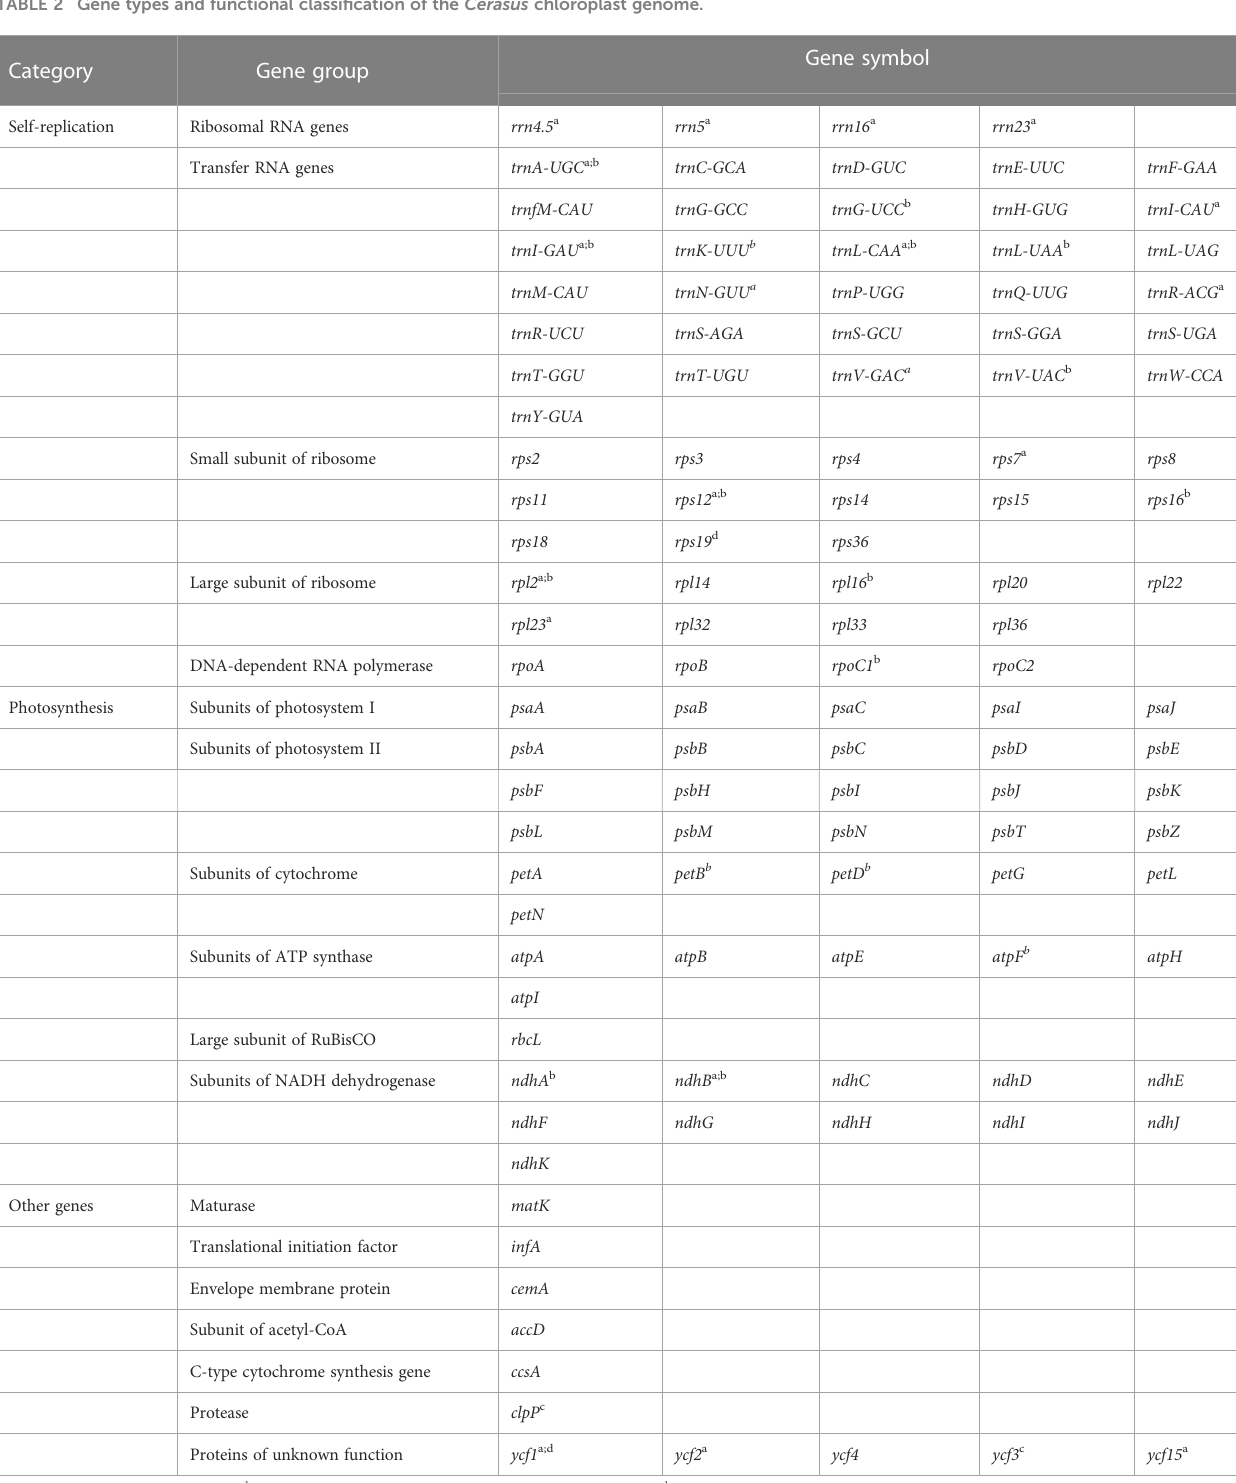
TABLE 2 Gene types and functional classi fi cation of the Cerasus chloroplast genome.